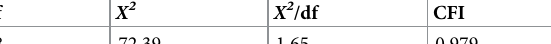
Table 2. Confirmatory factor analysis details of fit.